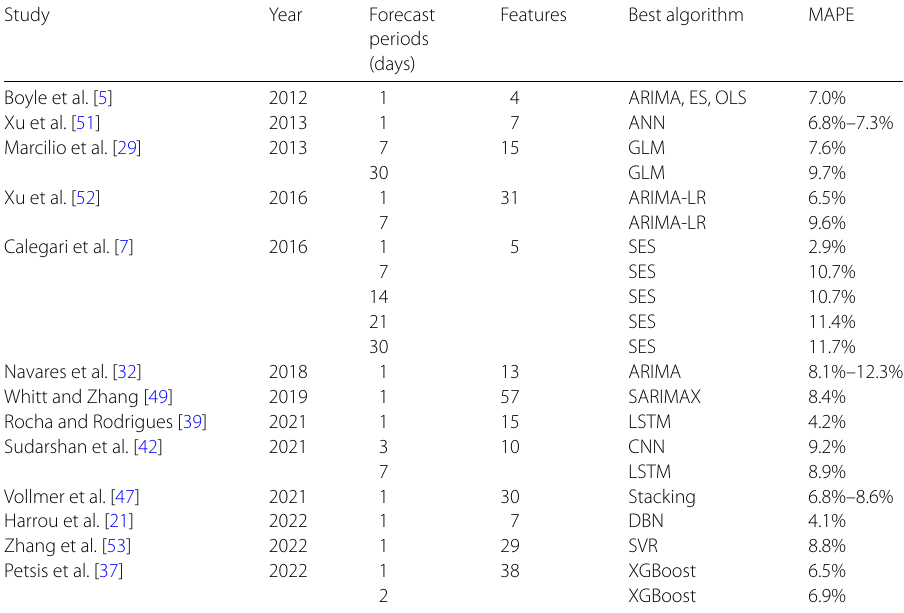
Table 1 Summary of literature predicting total daily patient flows in EDs, highlighting forecasting horizons, best algorithms and the accuracies achieved Study Year Forecast Features Best algorithm MAPE periods (days) Boyle et al. [5] 2012 ARIMA, ES,